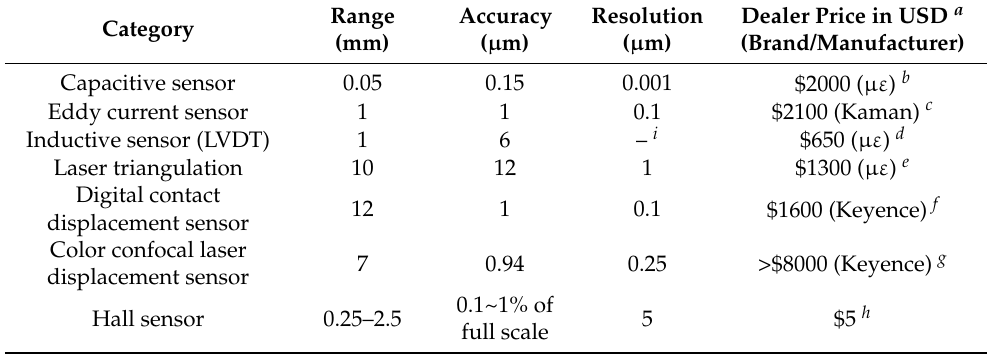
Table 1. Comparison of specifications and prices of typical commercially available displacement